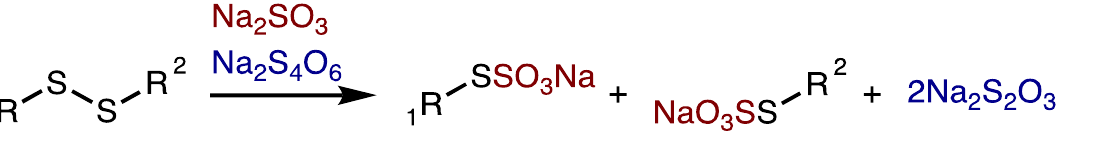
Scheme 1. A general reaction scheme for the oxidative sulfitolysis of a disulphide with sodium sulfite and sodium tetrathi- onate, resulting in formation of the S-sulfonate.